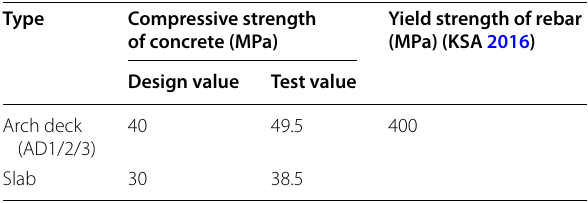
Table 1 Material properties.